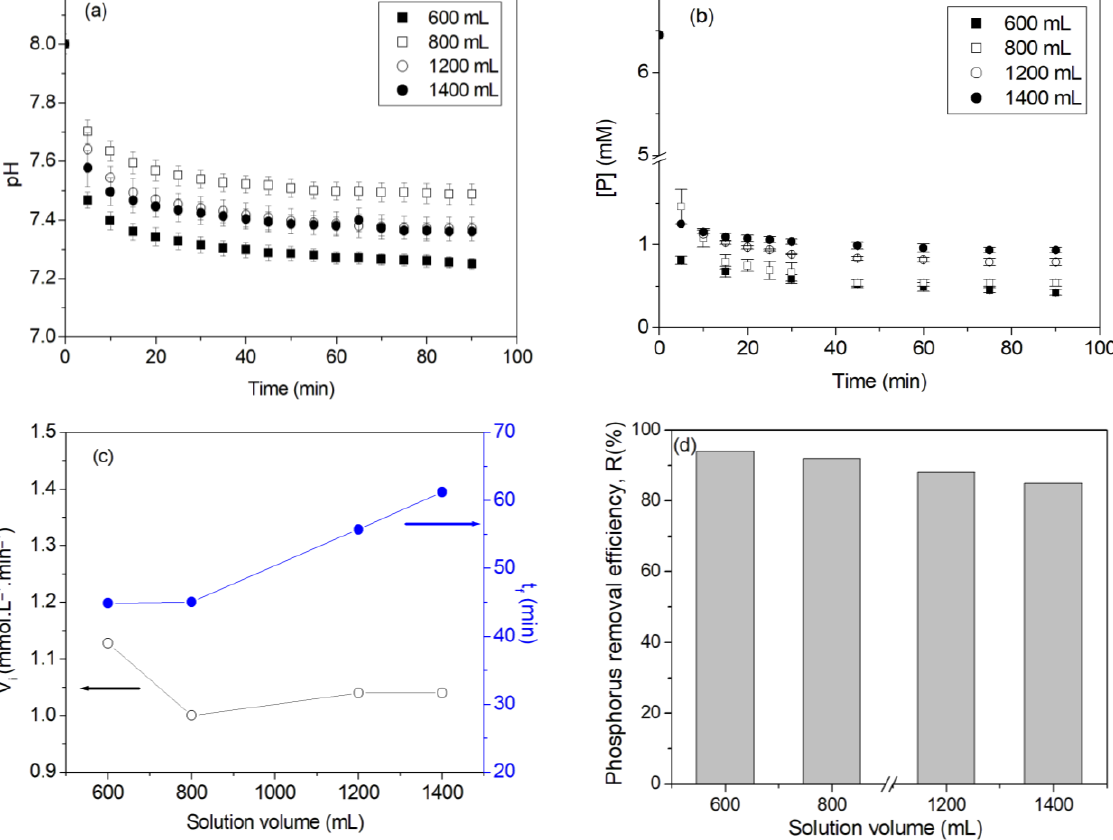
Figure 5. Variations of ( a ) pH, and ( b ) phosphorus concentration over time for different solution volumes, and variations of the ( c ) end of precipitation time t f and initial precipitation rate V i , and ( d ) phosphorus removal efficiency with the solution volume for an initial phosphorus concentration of 200 mg·L −1 and a stirring rate of 700 rpm.